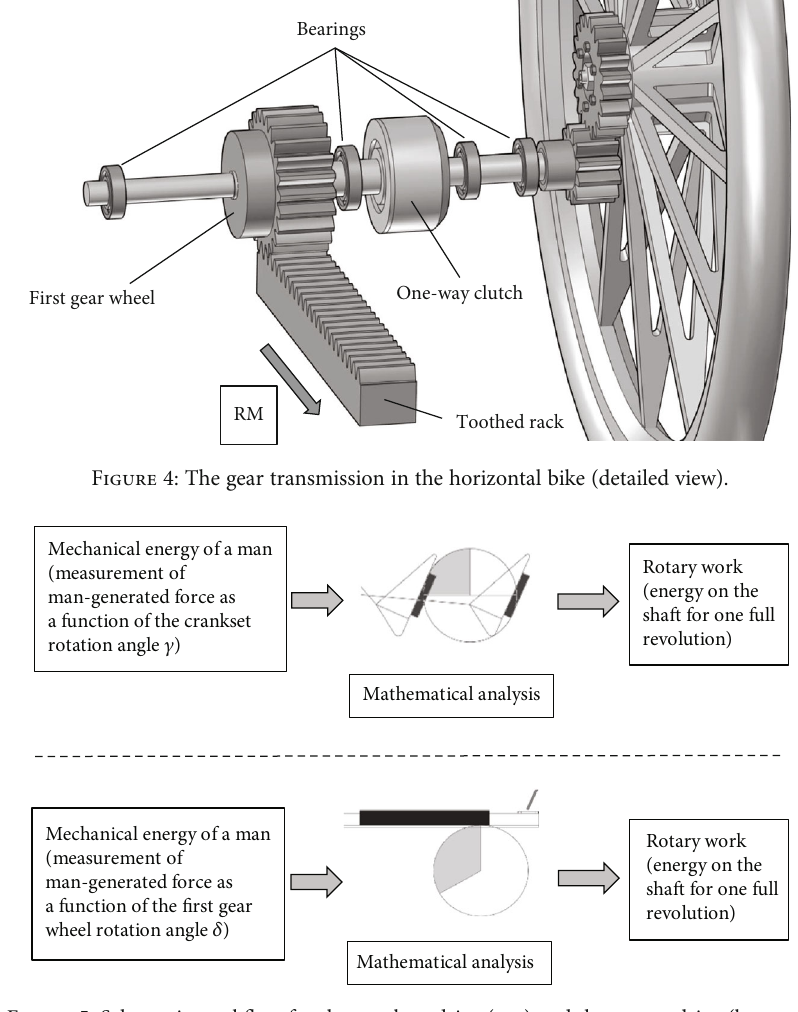
Figure 5: Schematic work fl ow for the crankset drive (top) and the gantry drive